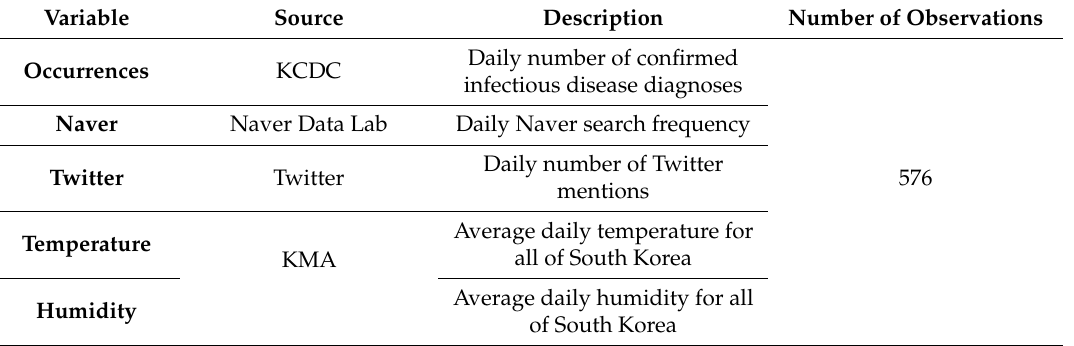
Table 1. Description of data types. KCDC: Korea Center for Disease Control; KMA: Korea Meteorological Administration’s weather information open portal.